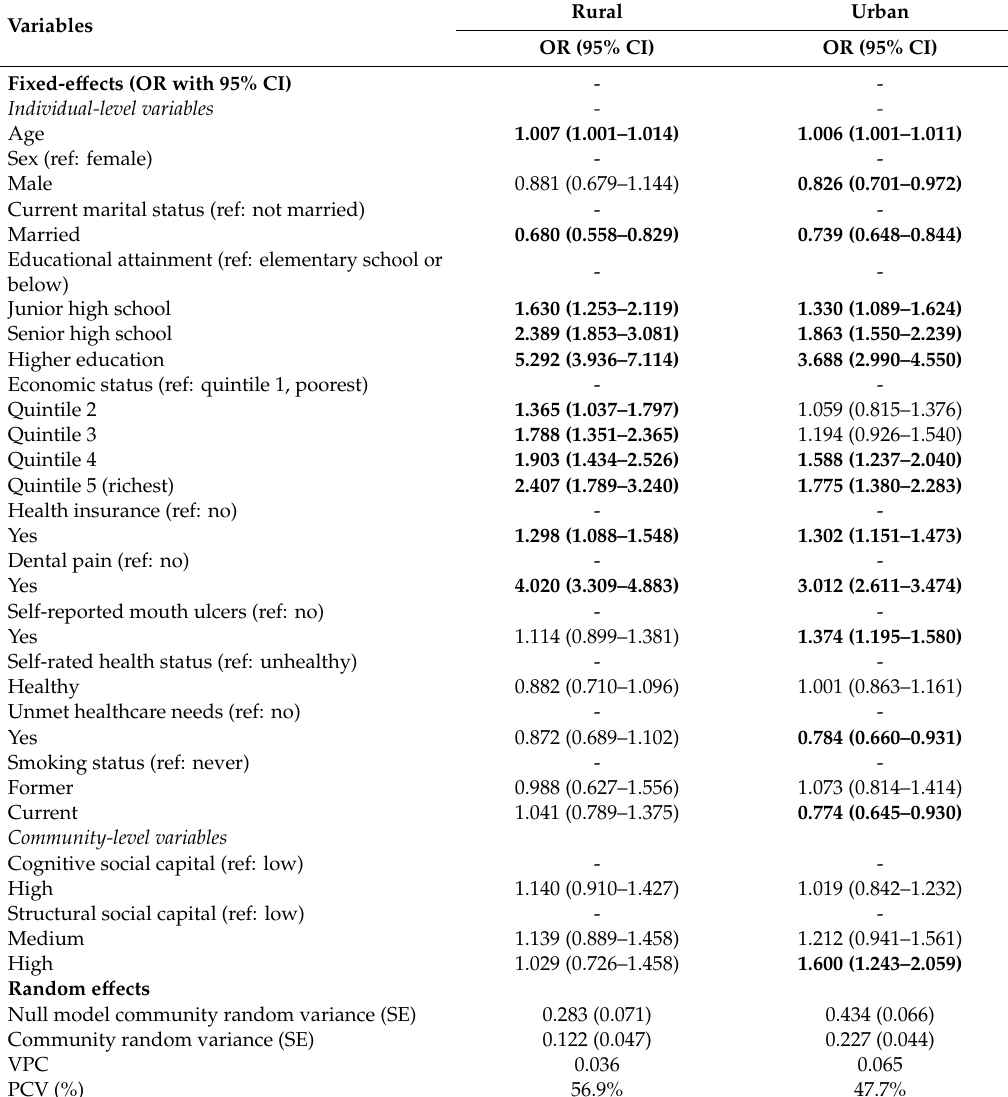
Table 3. Individual and community characteristics associated with dental service utilisation stratified by residential